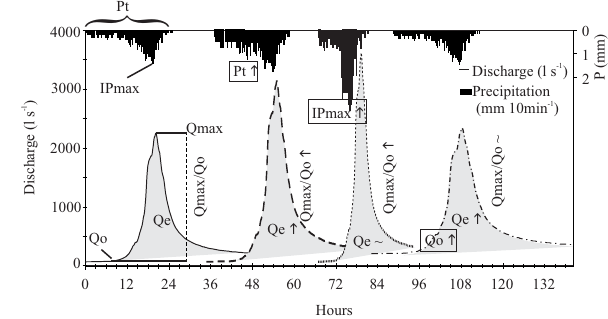
Fig. 7. Graphical interpretation of the influence of precipitation ( P t ), maximum precipitation intensity (IP max ) and initial discharge ( Q o ) in hydrological response of Aixola catchment ( Q max , Q e , Q max / Q o ). Timescale is approximate. (a) shows the parameters that are being assessed and is the original hydrograph that will change according to the changes in precipitation or initial discharge. (b) , (c) and (d) represent hydrographs generated when there is an increase in total precipitation ( b ), precipitation intensity ( c ) and initial discharge ( d